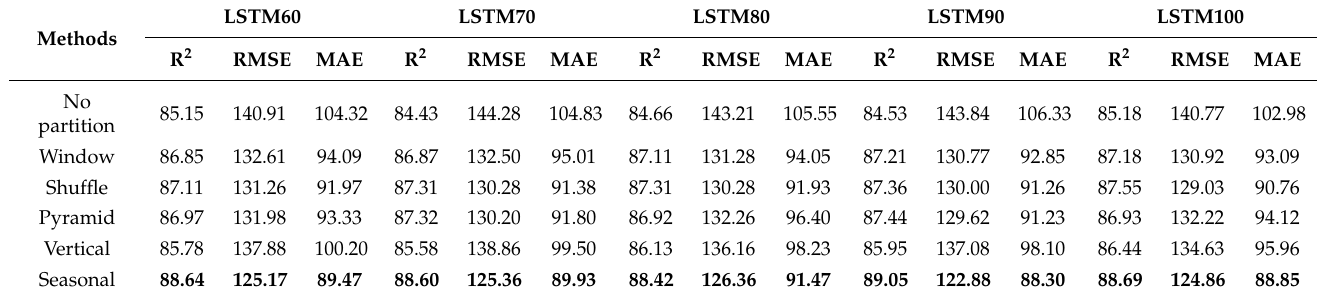
Figure 7. Results of daily forecasting of Site A.